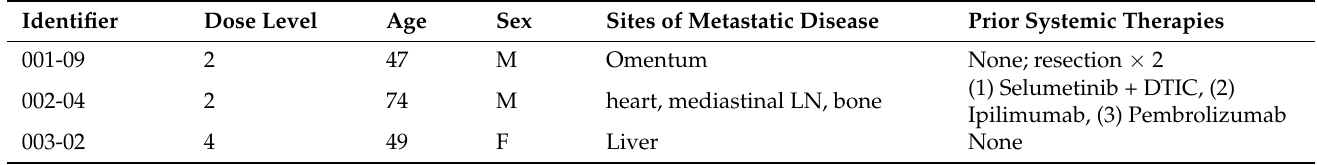
Table A2. Baseline characteristics for patients achieving stable disease > 20